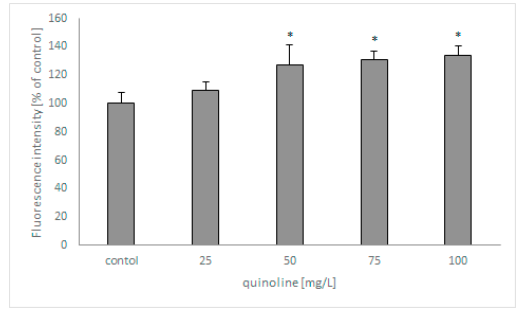
Figure 6. The effect of quinoline on the membrane permeabilization of C. lunata IM 4417. Asterisk ( p < 0.05) indicates values that differ significantly from the control.